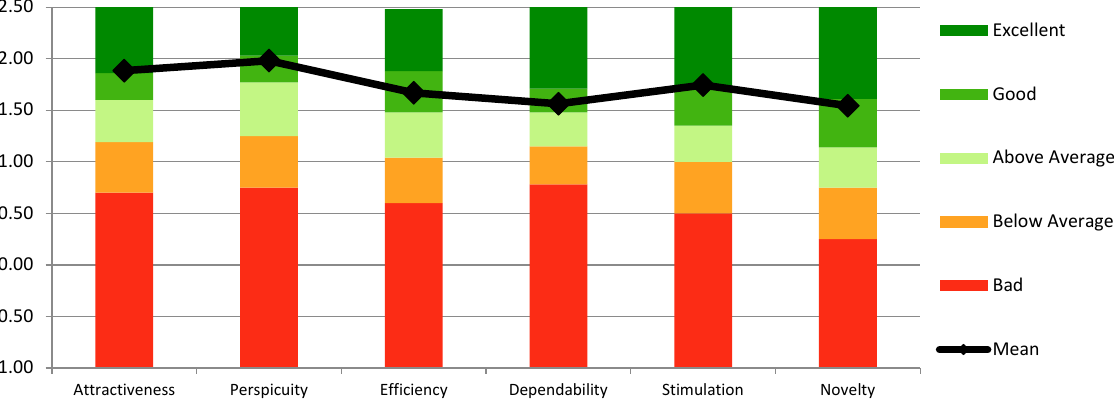
Figure 7. The User Experience Questionnaire (UEQ) scores reported by participants compared to the UEQ benchmark [22].